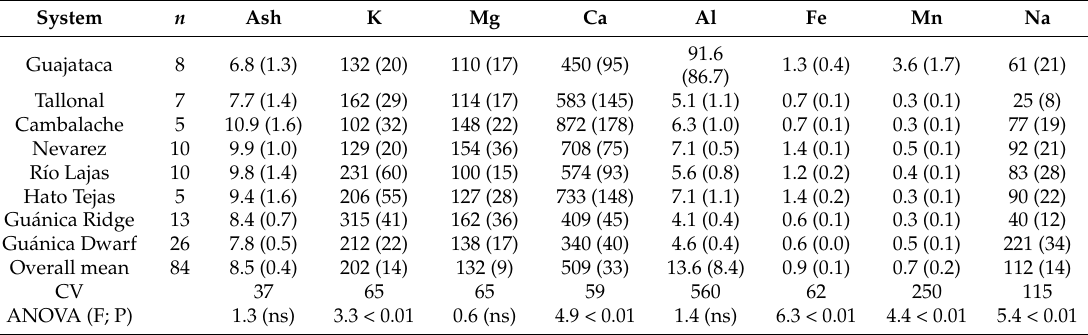
Table 4. Mean ( ± SE) concentrations of ash (%) and metallic elements in leaves per site in mmol/kg.